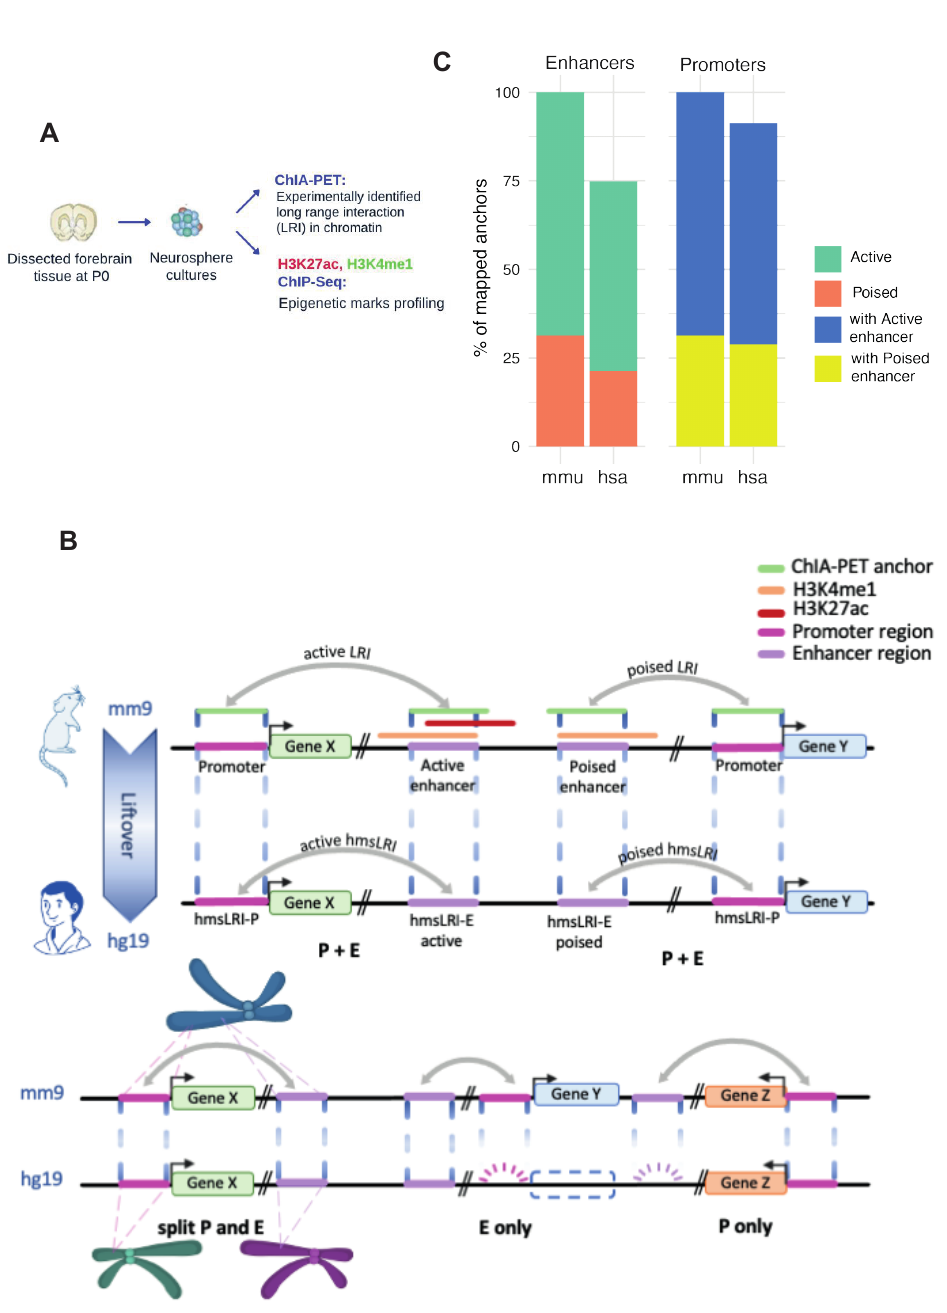
Figure 1. Identification of human DNA regions syntenic with mouse enhancer–promoter long- range interactions (LRI) . ( A ) Long-range interactions (LRI) identified by RNApolII ChIA-PET in neural stem cells (NSC) cultured in vitro from mouse neonatal forebrain, and regions carrying H3K4me1 and H3K27Ac histone modifications marks as identified by ChIP-Seq were obtained from (Bertolini et al., 2019) [10] ( B ) Graphical representation of the syntenic mapping between mouse (mm9) and human (hg19) reference genomes. Mouse LRI “anchors” that have syntenic correspondences in the human genome are indicated as hmsLRI-P (promoter) or hmsLRI-E (enhancer). ( C ) The percentages of mouse promoter and enhancer anchors that “lifted over” to the human genome (imposing a 50% minimal overlap, see